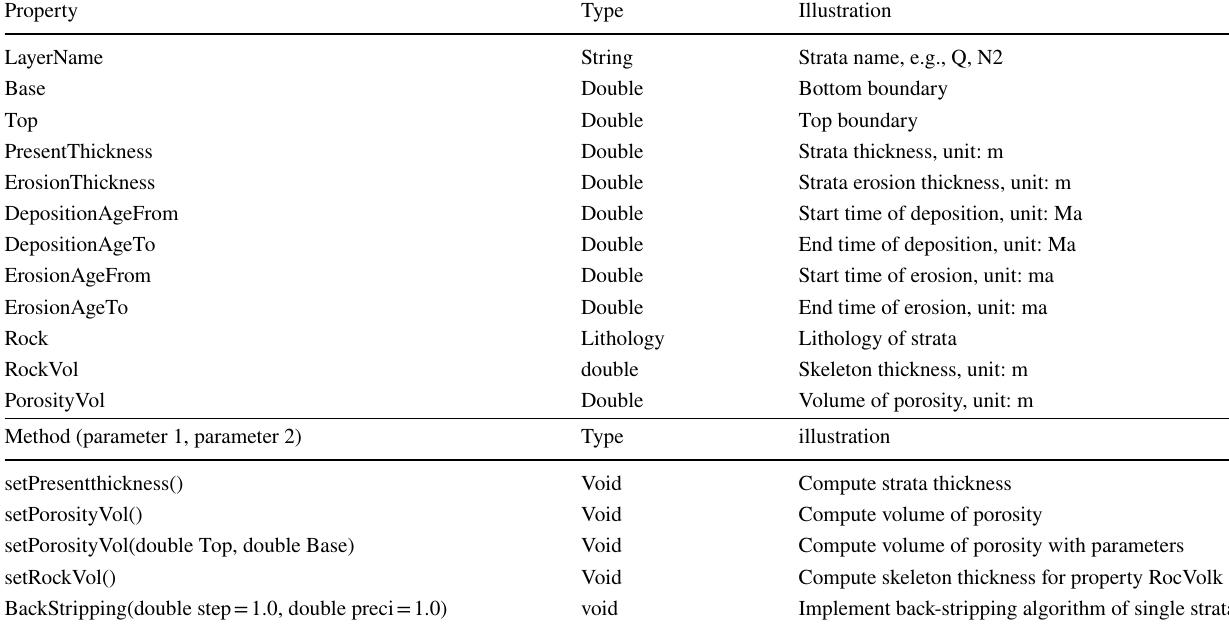
Implement back-stripping algorithm of single strata